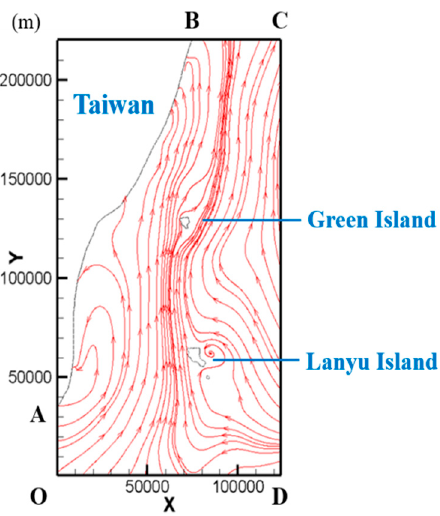
Figure 2. Study domain and boundaries, as well as streamlines from the hybrid coordinate ocean model) (HYCOM).